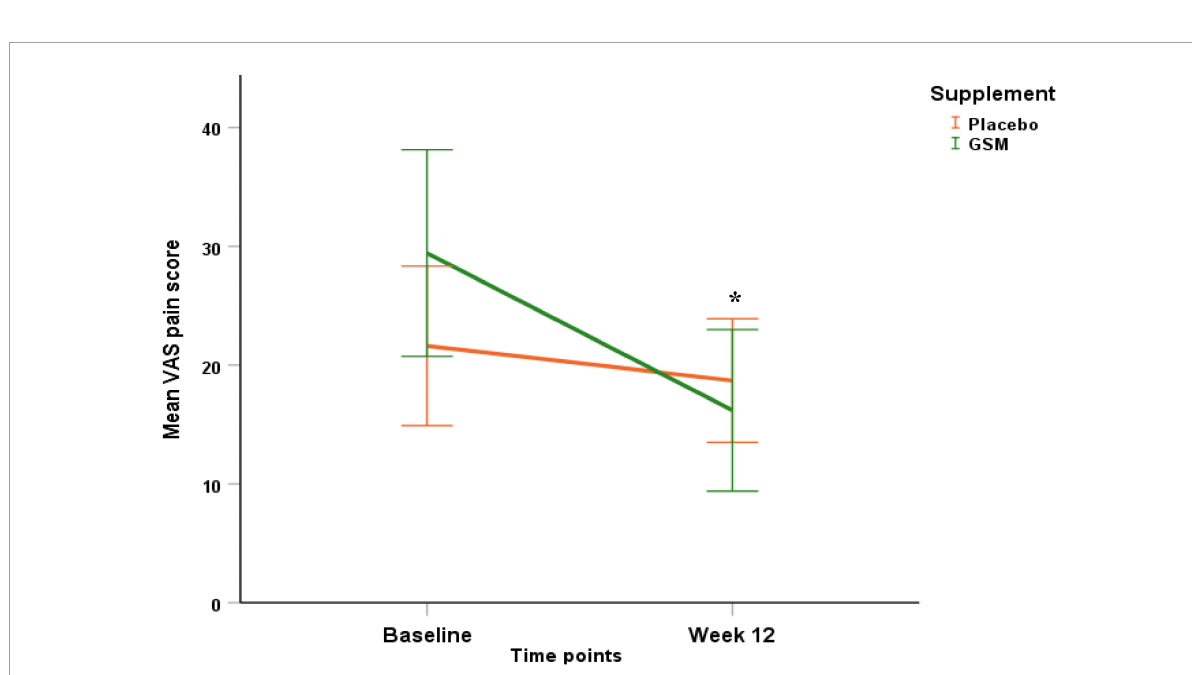
FIGURE4 Pattern of change in visual analogue scale (VAS) pain score over the study period (baseline and endpoint) within each of the treatment groups. Significant effect of time ( P = 0.002), and greater reduction in VAS pain score in GSM supplement compared to placebo (interaction effect P = 0.03 unadjusted and P = 0.04 adjusted for baseline level, compliance, use of paracetamol and season of enrolment). Placebo = orange, GSM = green. Values are expressed as mean (95% confidence interval). *Indicates the significance ( P <